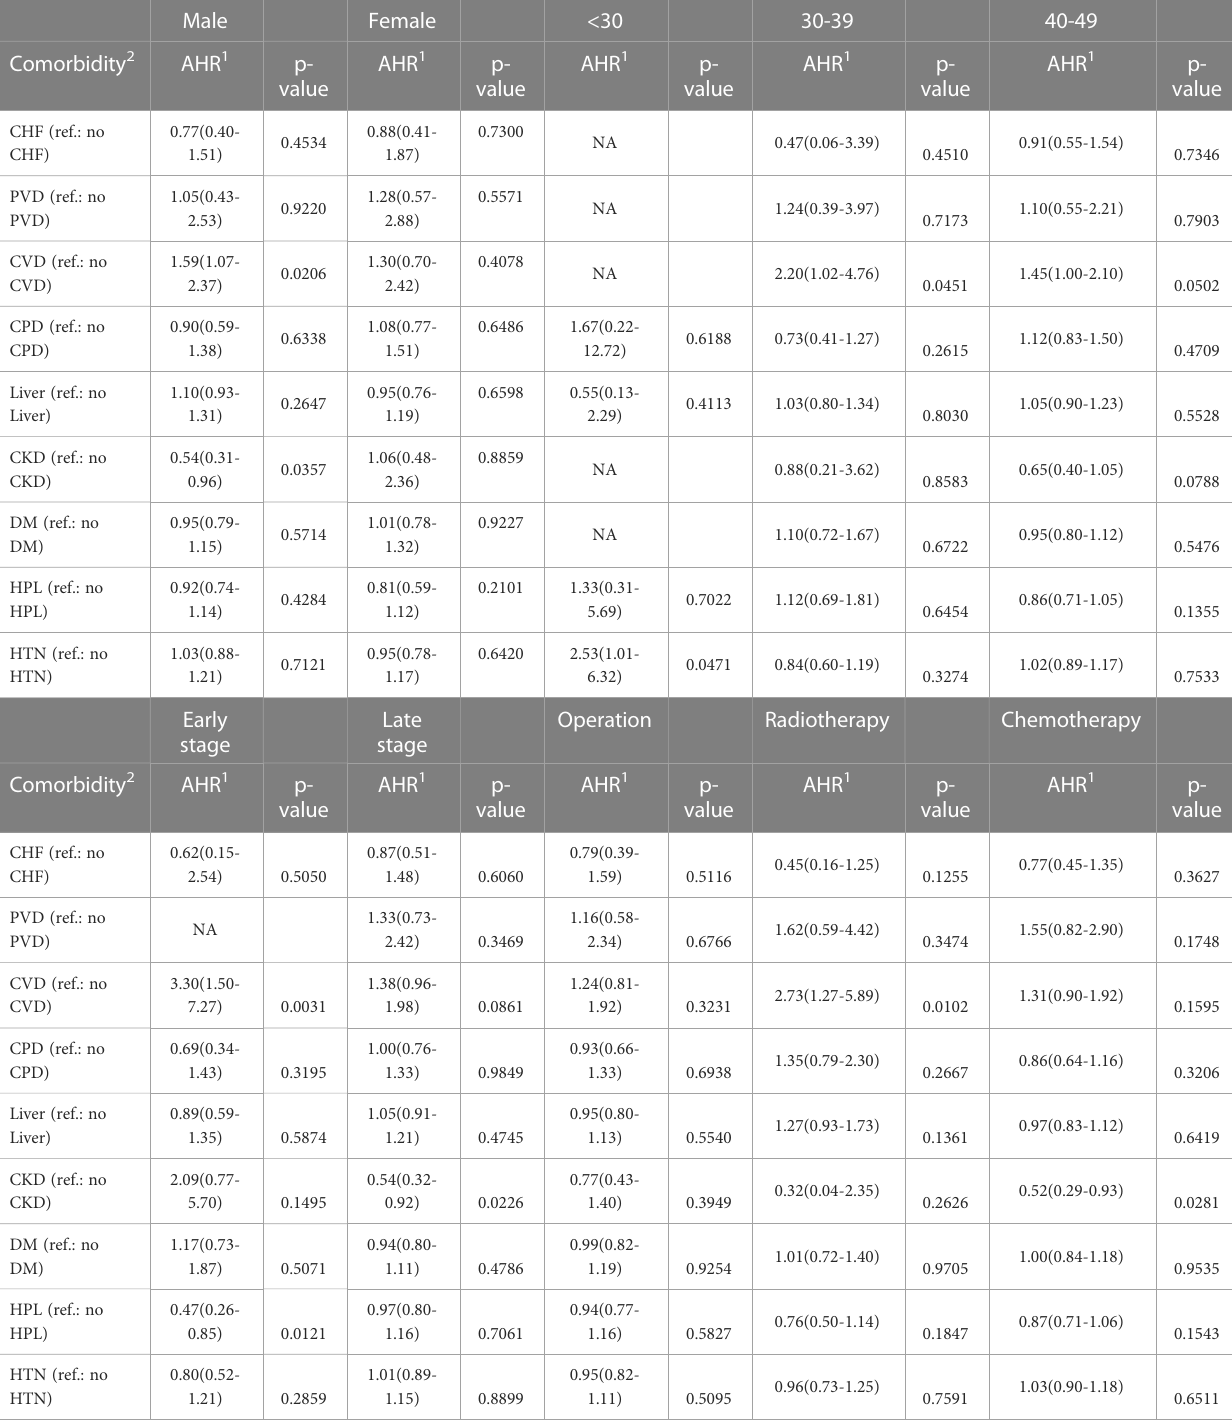
TABLE 4 The subgroup analysis of 5-year cancer-speci fi c mortality risk among EO-CRC patients of different sex, age, clinical stages, and treatment types. Male Female <30 30-39 40-49 Comorbidity 2 AHR